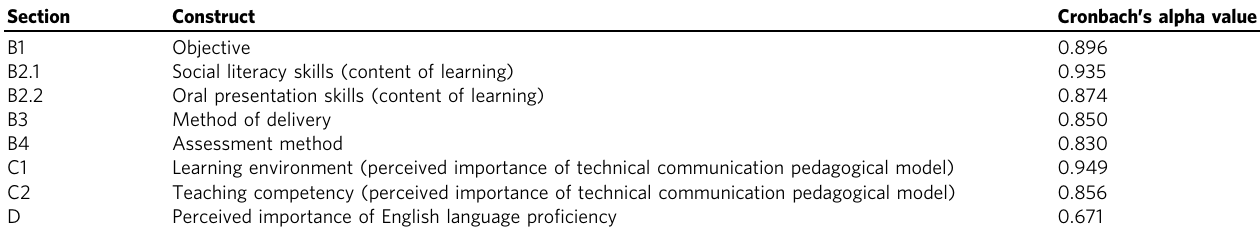
Table 3 The Cronbach ’ s alpha measure of